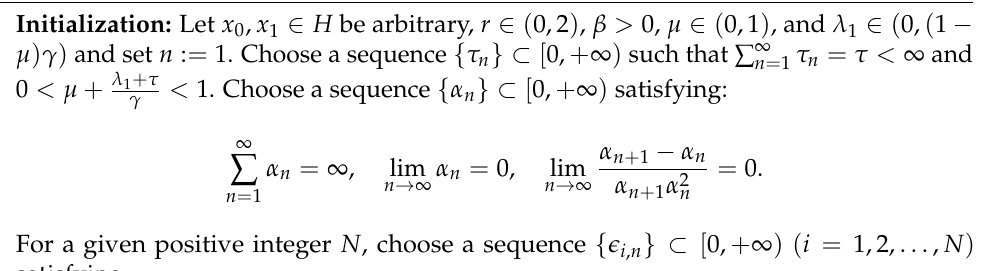
Algorithm 2 Modified multi-steps inertial proximal contraction method with